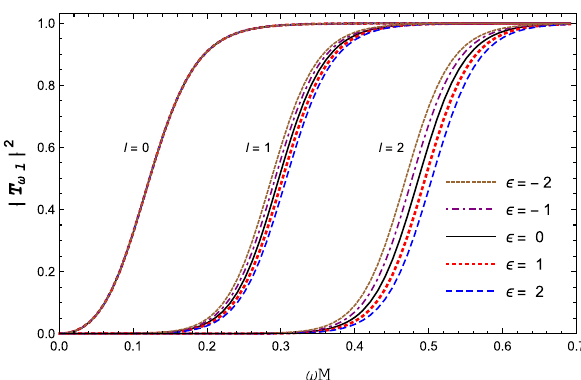
Fig. 10 Transmission coefficients for the first three modes ( l = 0, l = 1 and l = 2), for different choices of the deformation parameter ( ε = − 2, − 1, 0, 1 and 2). The transmission coefficients for l = 0 are the same for any value of the deformation parameter, while for non-vanishing angular momentum they are different, and the difference increases for higher values of l